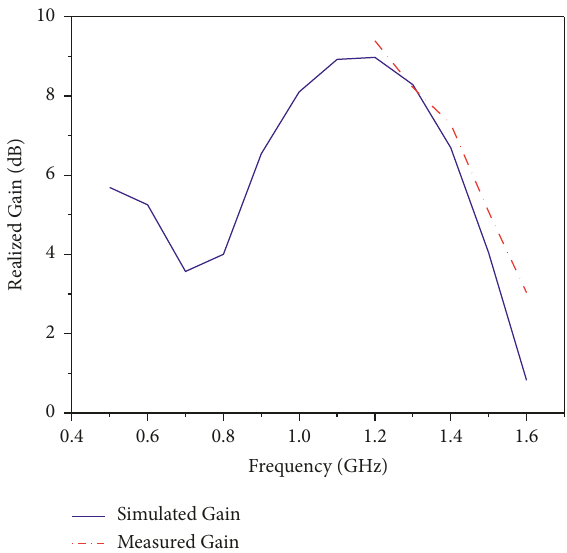
Figure 14: Simulated and measured realized gains of the proposed